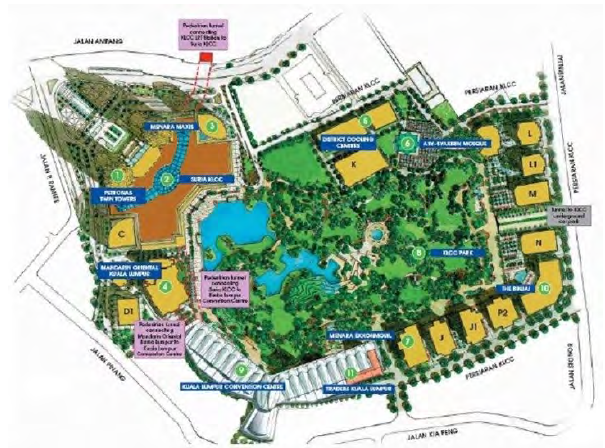
Figure 6. The master plan of KLCC Park Kuala Lumpur (Source: Magazine, 2005).